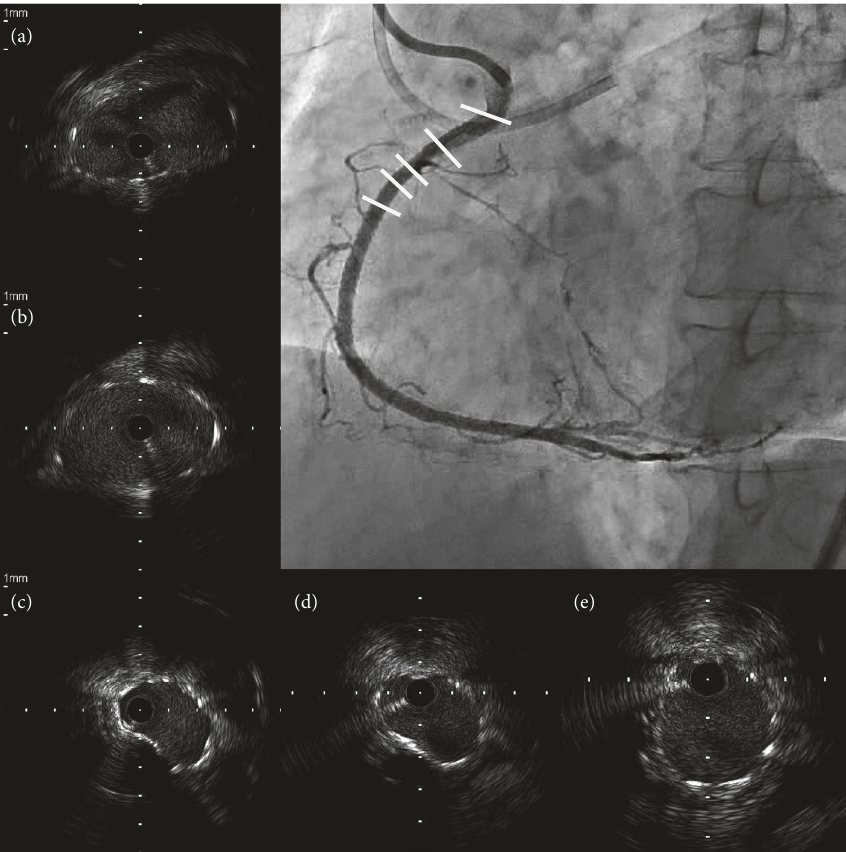
Figure 6: A final angiogram reveals an acceptable outcome. Serial intravascular ultrasound images of right coronary artery (RCA) after stenting show the ostial RCA (a), RCA proximal to chronic total occlusion (CTO) (b), and the CTO segments ((c)–(e)). Images are viewed in a proximal (a) to distal (e) direction. Adequate stent expansion is achieved throughout the lesion, except elliptical stent expansion limited by a superficial calcified lesion at the calcified proximal cap of CTO